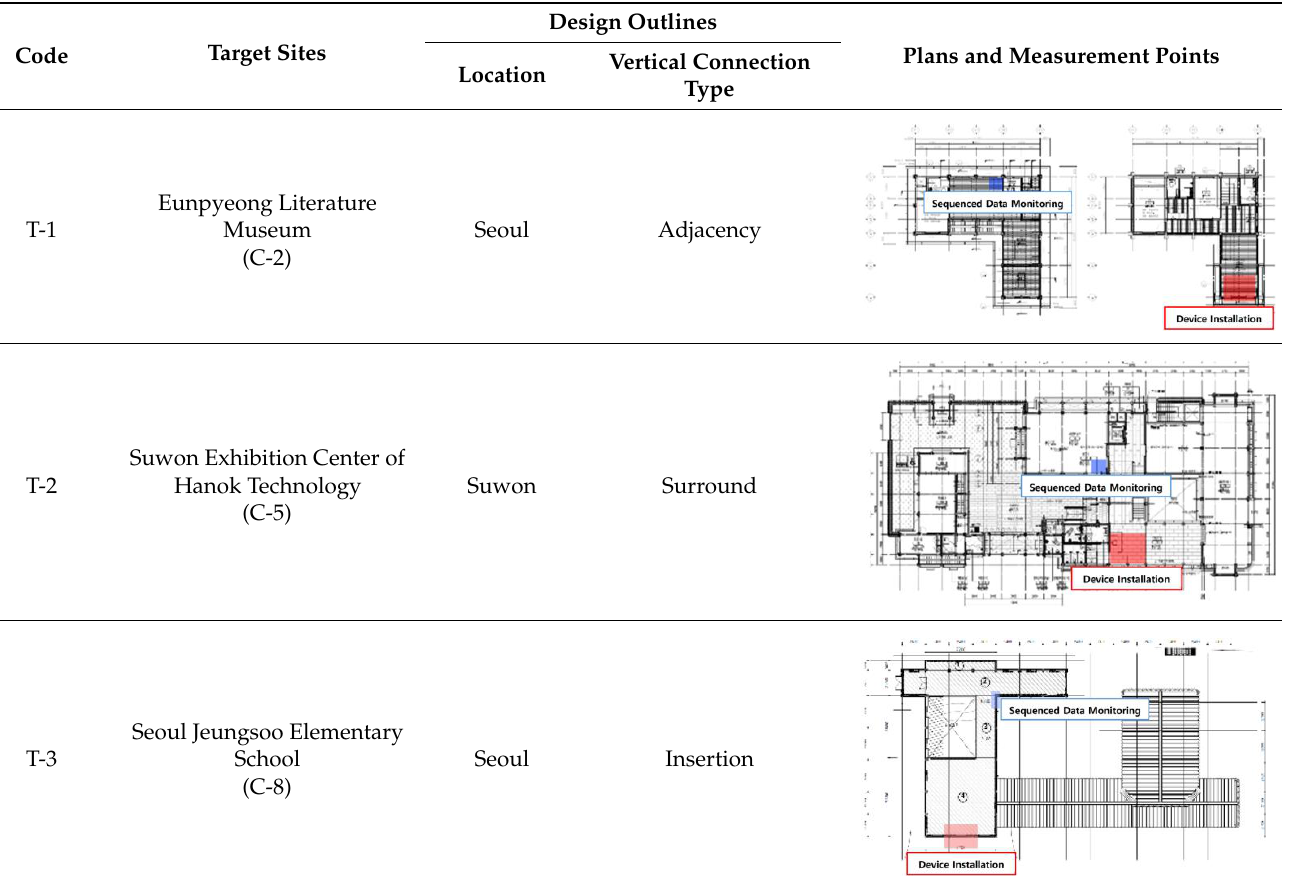
Table 4. Plans and measurement scheme of final target Hanoks.